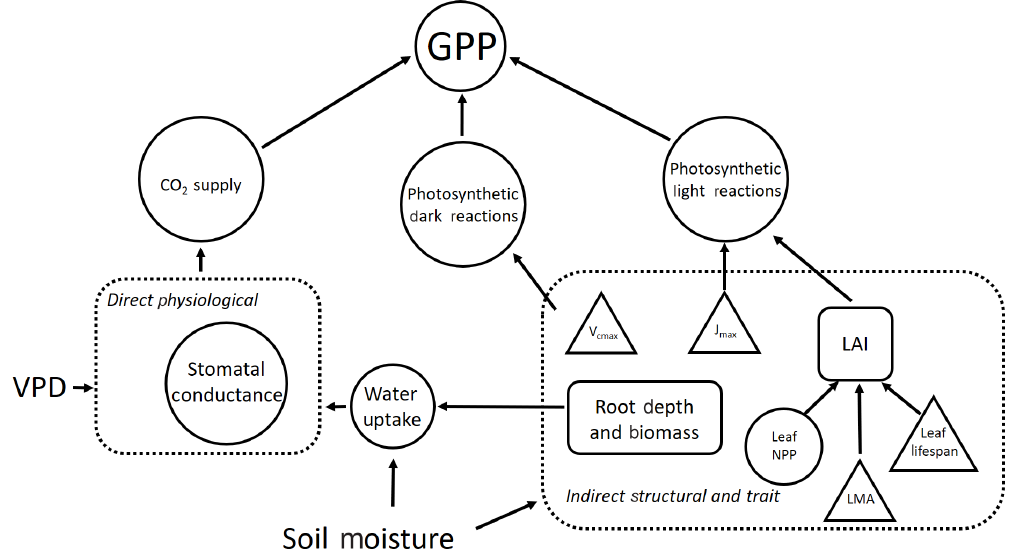
Figure 1. A schematic of the direct and indirect effects of drought stress via soil moisture and VPD on GPP. Drought stress affects GPP directly via stomatal conductance and indirectly through its determinant effect on plant traits and structural properties. Plant processes are represented by circles, traits are represented by triangles and vegetation properties (i.e. ecosystem structure) are represented by rectangles. Dashed boxes identify interactions driving the direct and indirect pathways through which drought stress impacts GPP. We note that other climate forcings (e.g. shortwave radiation and temperature) impact GPP but are not included